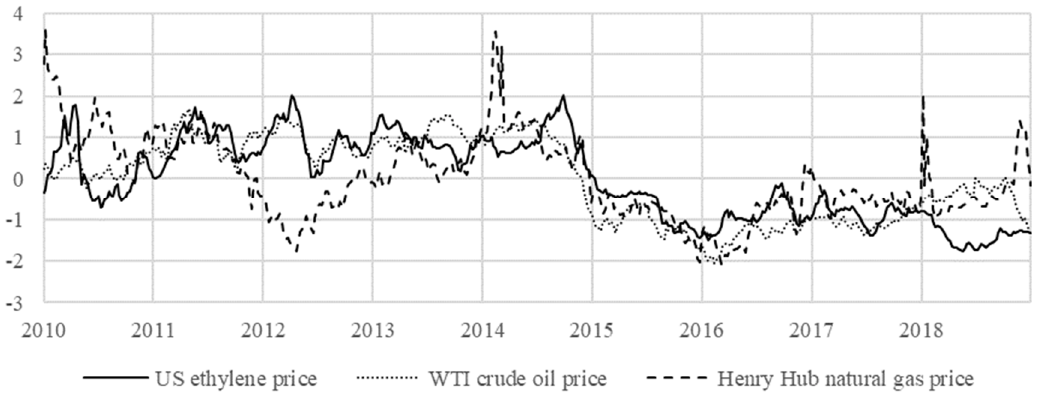
Figure 1. Trends of ethylene prices in the US, Japan, and Northwest Europe.